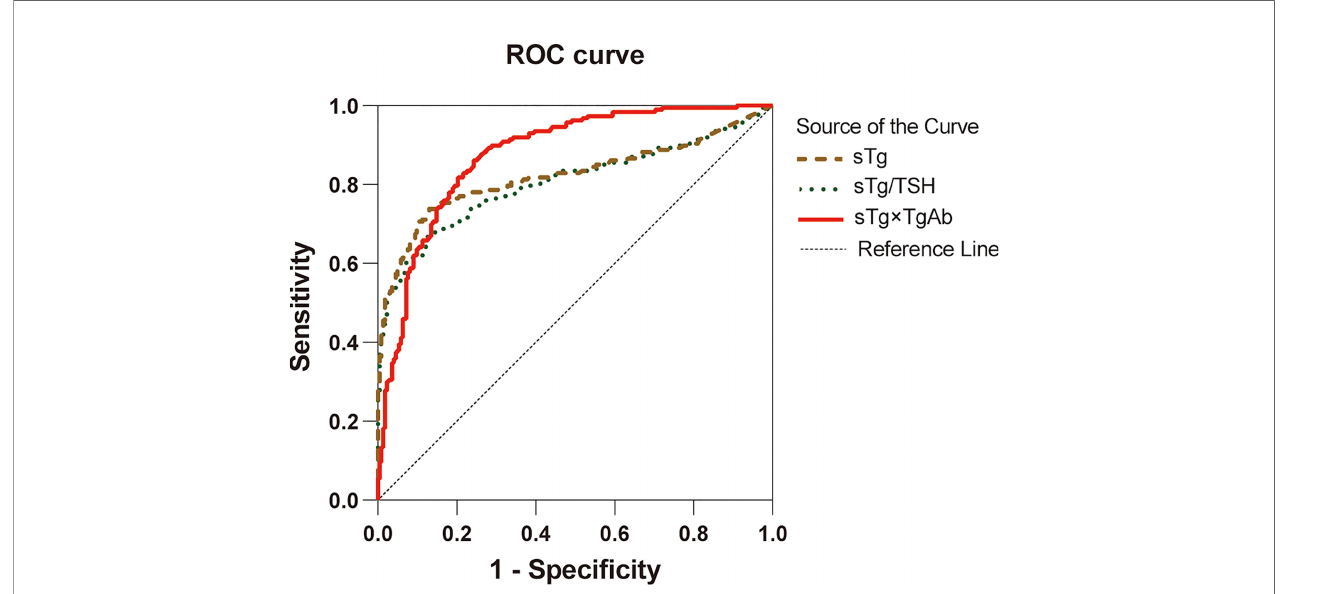
FIGURE 2 | ROC curves for sTg, sTg/TSH ratio, and sTg×TgAb product before initial RAIT to predict unsuccessful